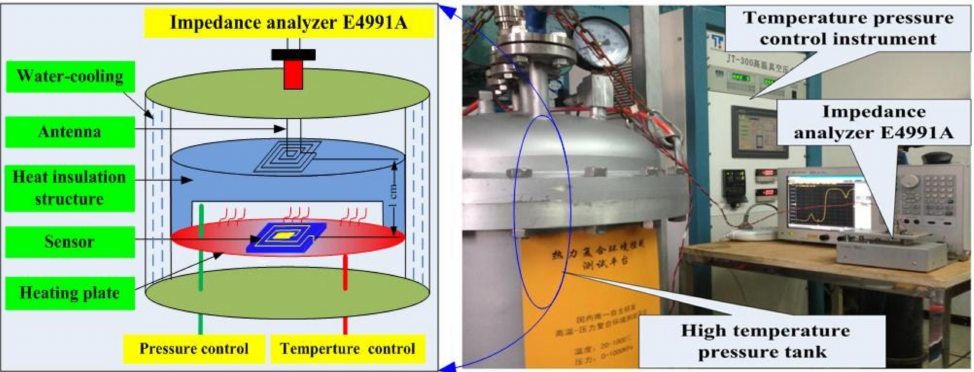
Figure 6. Side view of the measurement system platform.